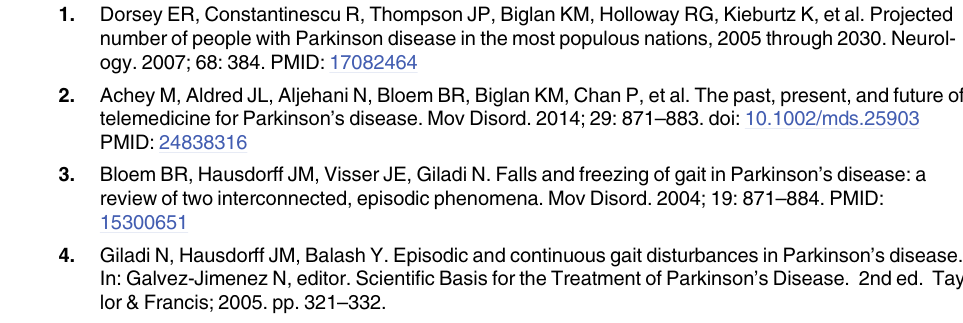
S1 Table. Group-level means and standard deviations associated with step outcome mea- sures. S2 Table. Group-level means and standard deviations associated with step length outcome